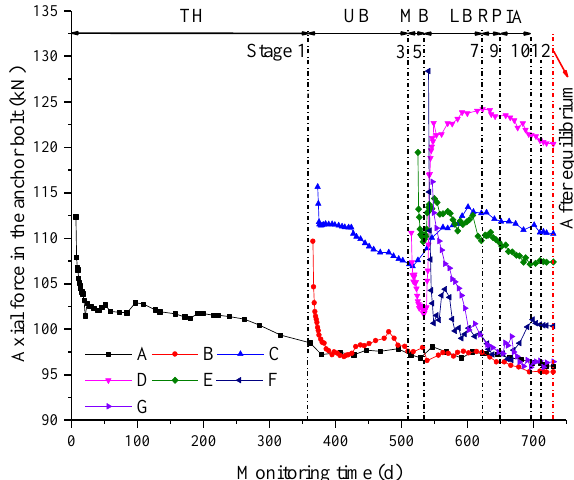
Figure 21. Evolution of the axial forces at the end of the anchor bolts.